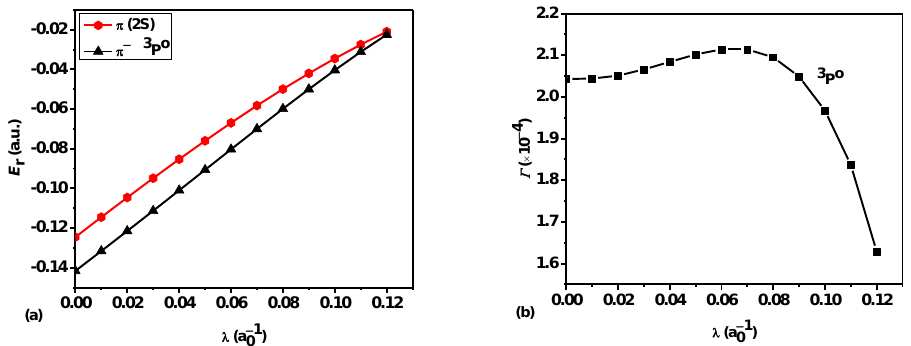
Figure 12. ( a ) Plot of the lowest 3 P o resonance energy 𝐸 𝑟 of π − as a function of 𝜆 . ( b ) Plot of the corresponding resonance width 𝛤 of π − as a function of 𝜆 .